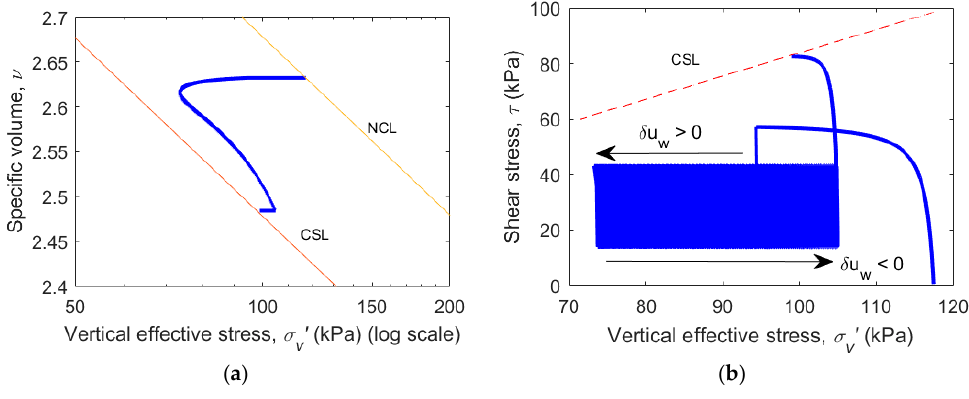
Figure 11. Evolution of soil strength: ( a ) υ – σ v ’ plane; ( b ) τ – σ v ’ plane.